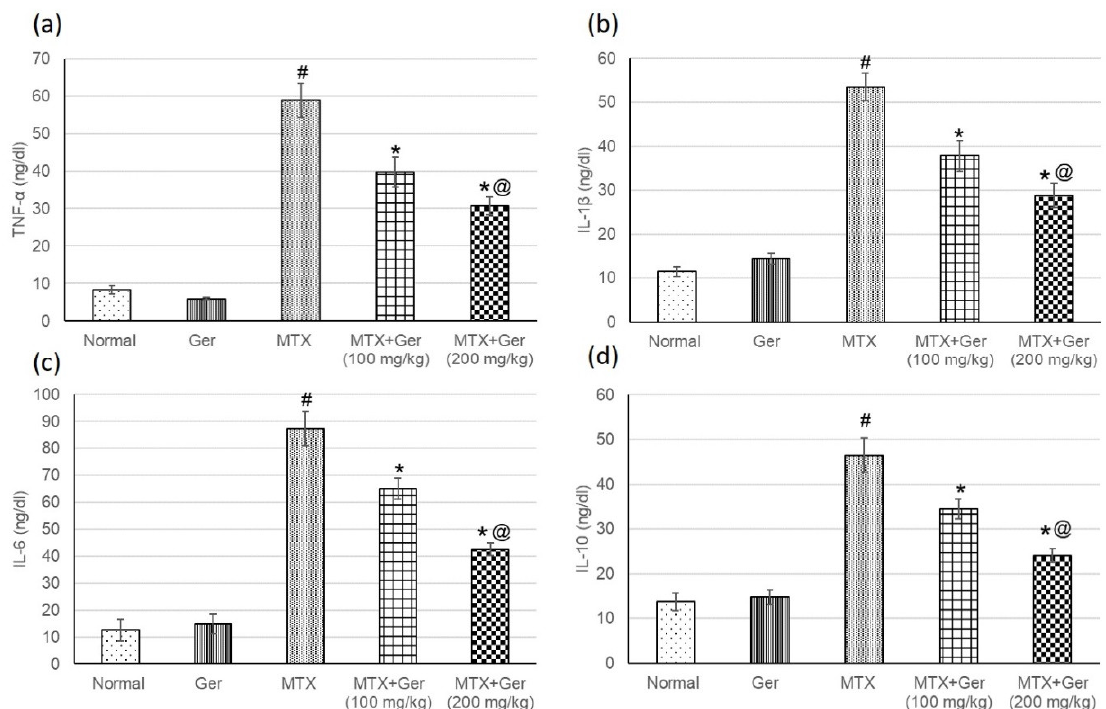
Figure 5. Effects of treatment with Ger (100 and 200 mg/kg) for 19 days on the inflammatory mediators including ( a ) TNF- α , ( b ) IL-1 β , ( c ) IL-6 and ( d ) IL-10 in MTX-induced AKI in rats ( n = 6). All values are expressed as mean ± SD. #, statistically significant from normal group; *, statistically significant from MTX-only group; @, statistically significant from MTX + Ger 100 mg/kg group ( p < 0.05) using one-way ANOVA followed by Tukey’s post hoc analysis.